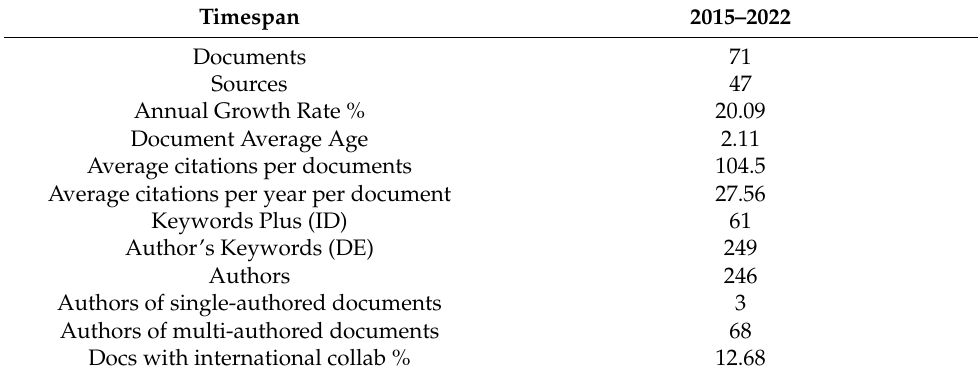
Table 1. Summary of corpus.